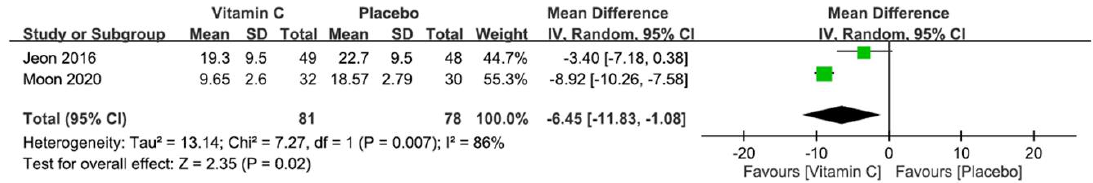
Figure 9. Forest plot for the comparison of opioid consumption (mg) within postoperative 24 h between vitamin and placebo groups. CI, confidence interval; IV, inverse variance. 3.4.7. Opioid Consumption within 48 h after Surgery Two studies utilizing PCA for postoperative pain control in a total of 122 patients (vitamin group, n = 62 vs. placebo group, n = 60) [26,27] were available for analysis, which showed a lower level of morphine consumption in the vitamin group than that in the placebo group (WMD = −10.49 mg, 95%